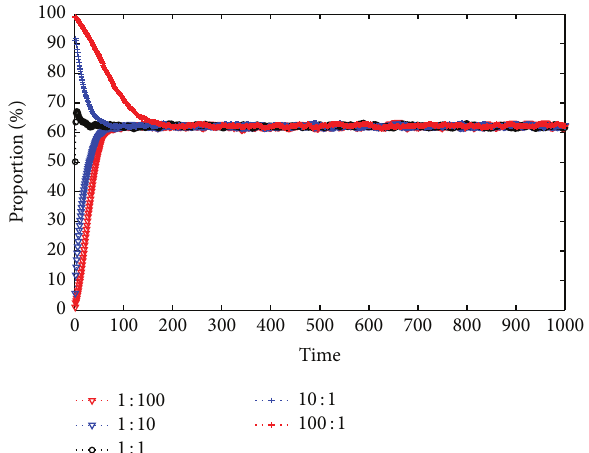
Figure 1: The proportion evolution of the “greedy” strategy for the five different initial cases.